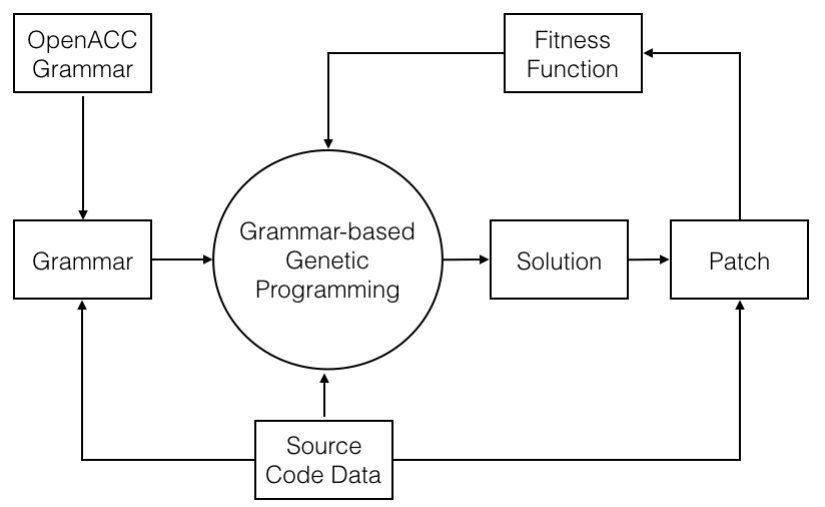
Figure 1: The Architecture of GB-GP-Parallelisation